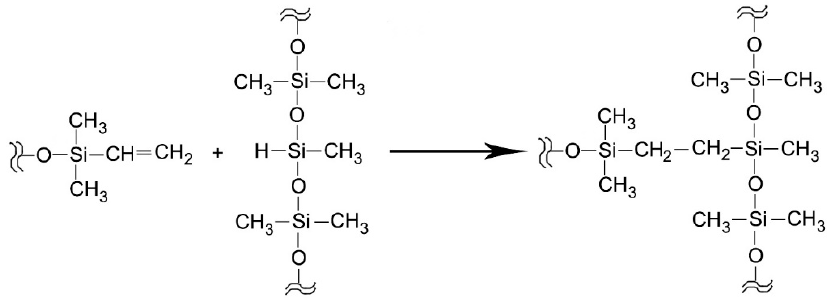
Figure 10. Mechanism of the hydrosilylation reaction.